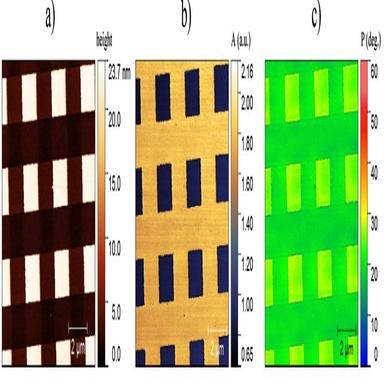
DM sample (Al2O3 as substrate and Pt thin film). Imaging was performed at the edge of the Pt film; (a) AFM topography; (b) s-SNOM 3rd harmonic amplitude; (c) s-SNOM 3rd harmonic phase.